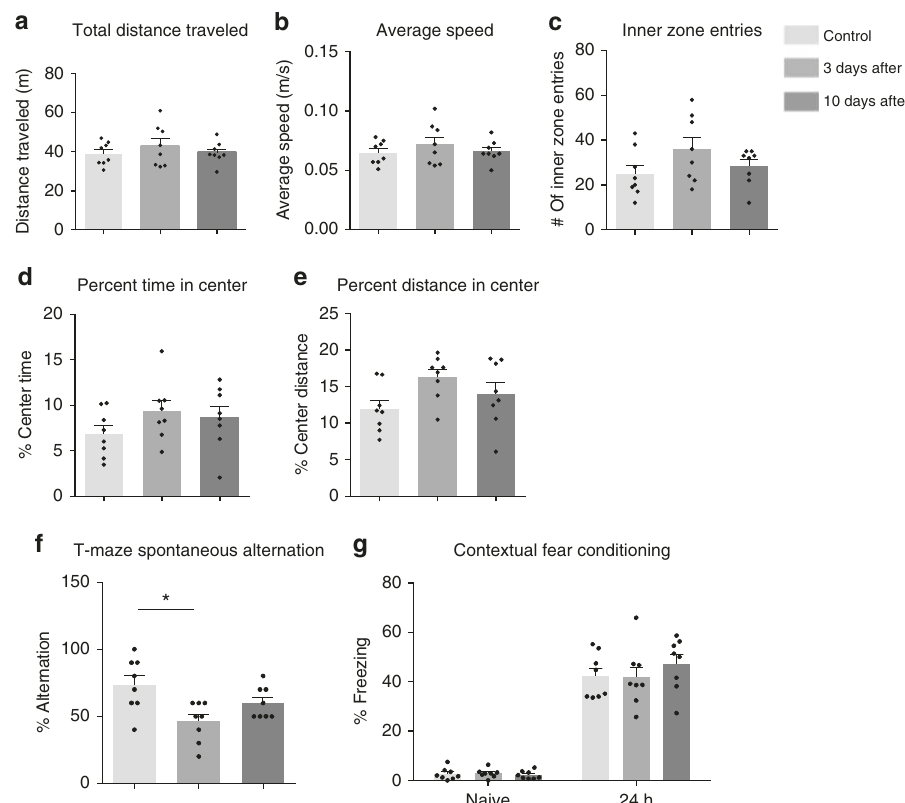
Fig. 8 The effect of C. albicans cerebritis on mouse behavior. a – e After the intravenous injection of 25,000 viable cells of C. albicans into wild-type C57BL/6 mice, open- fi eld tests were conducted on days 3 and 10 post fungal challenge to determine total distance traveled ( a ), average speed ( b ), inner zone entries ( c ), percent time in center ( d ), and percent distance in center ( e ). Mice were subsequently assessed in the T-maze spontaneous alternation task ( f ) and contextual fear conditioning ( g ). ( n = 8, mean ± S.E.M, * p < 0.05, using one-way ANOVA followed by Dunnett ’ s test for multiple comparison). Data are shown as representative of two independent